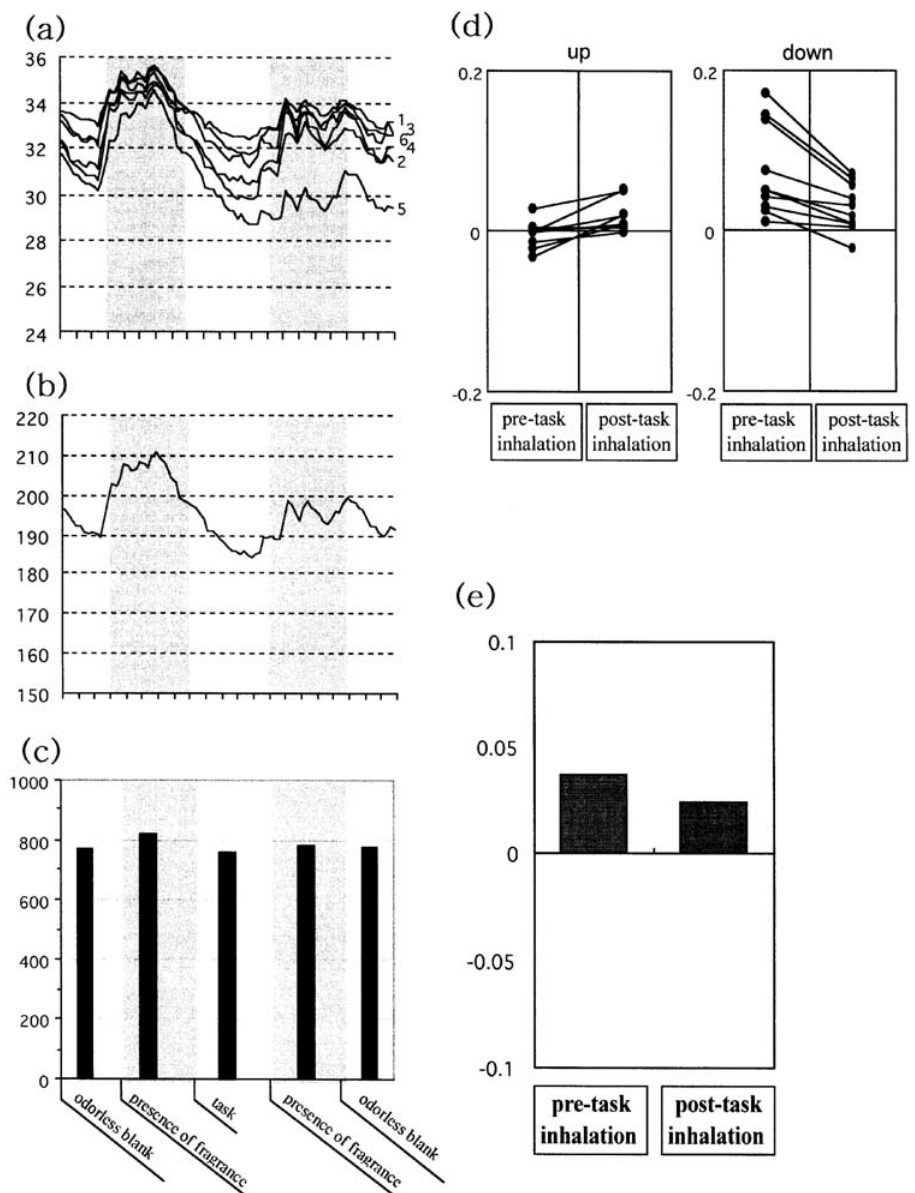
association with the auditory task. Redrawn from Sugawara et al. [15]. The numbers assigned to the graph represent the sensor spots on the left hand: 1, the tip of the thumb; 2, the tip of the first finger; 3, the tip of the second finger; 4, the tip of the third finger; 5, the tip of the fourth finger, and 6, the palm. The number of subjects was